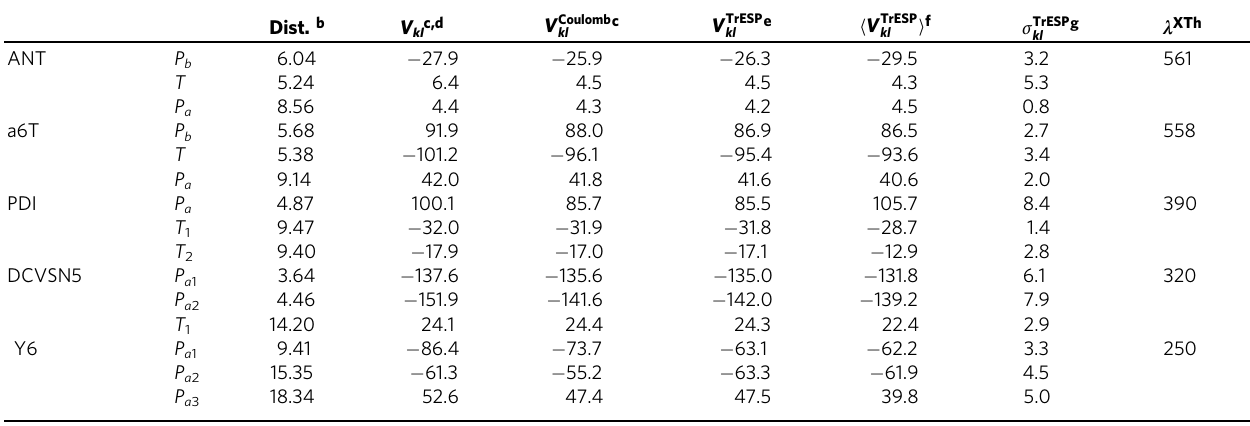
Table 1 Computed parameters for exciton transport in the molecular OSs shown in Fig. 1. All values in meV (except distances in Å ) a .